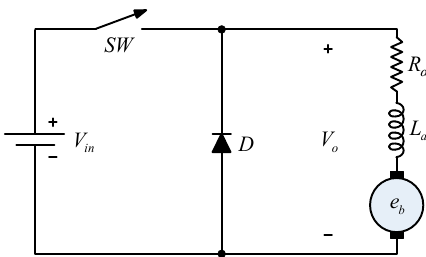
Figure 11. One-quadrant hard switching DC motor drive.